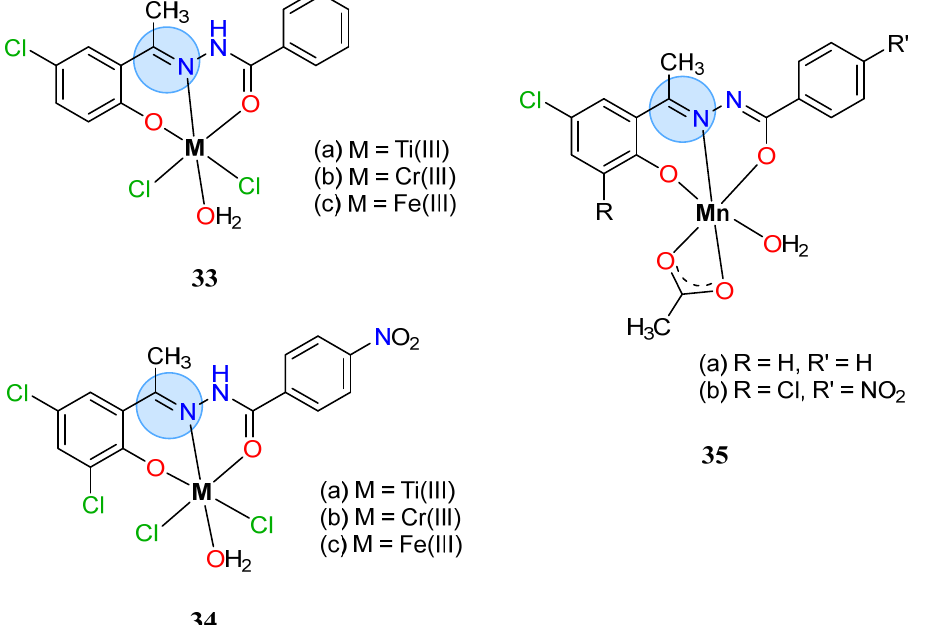
Figure 16. Ti(III), Cr(III), Fe(III), and Mn(III) complexes containing tridentate hydrazone with anti ‐ bacterial activity.